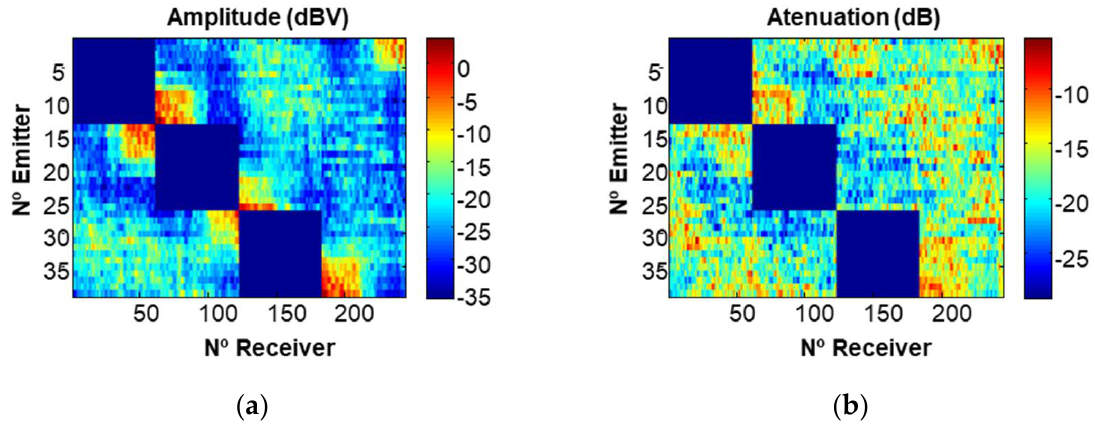
Figure 17. Obtained sinogram: ( a ) amplitude; ( b ) attenuation.